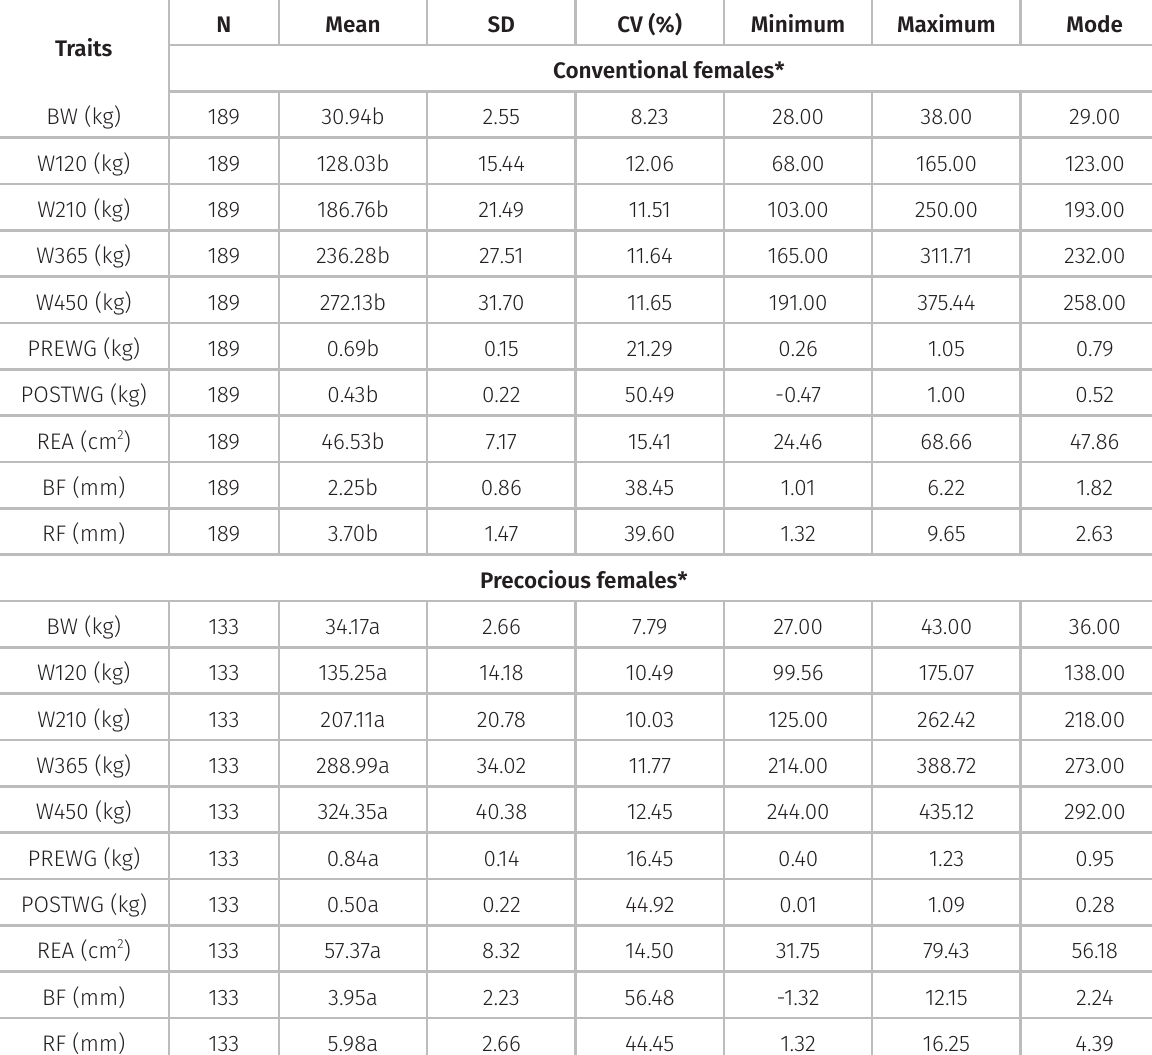
Table II. Descriptive statistics and variance analysis results of t-test for growth and carcass traits for conventional and precocious